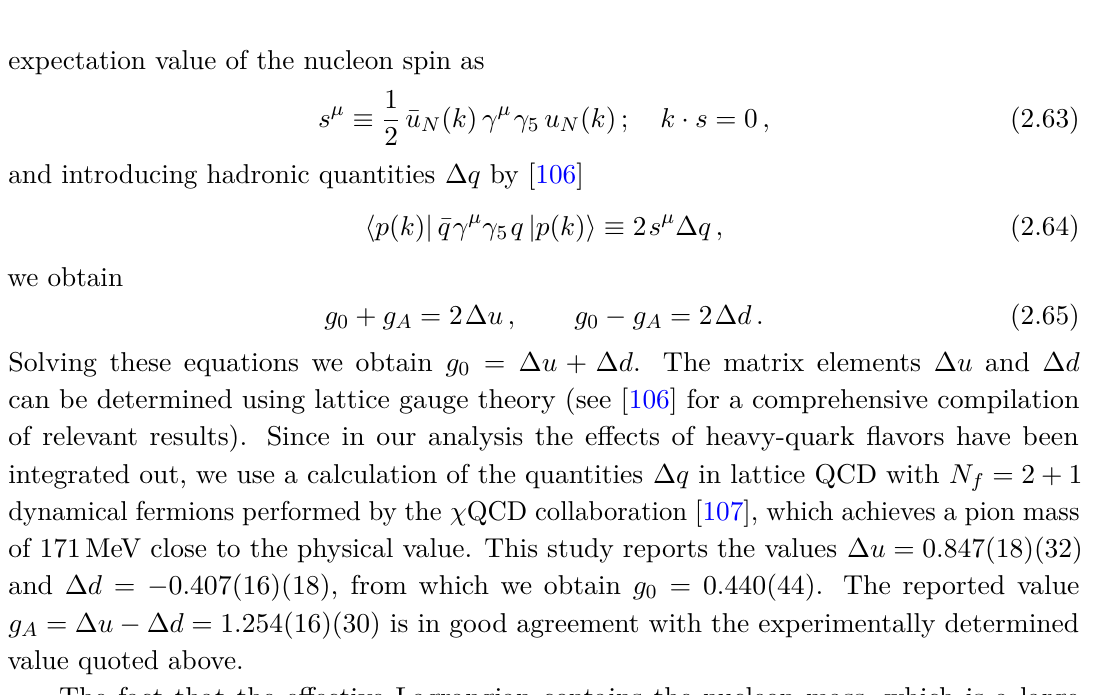
( g + g ) / 2 (blue), in units of the ALP-gluon singlet ≡ pa na = c = 0 ). uu dd